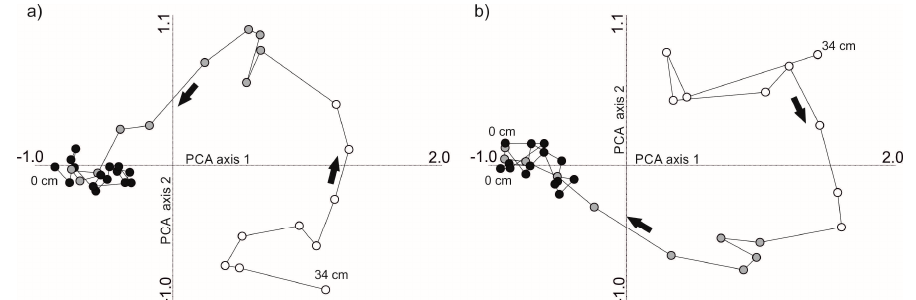
Figure 5. Principal component analysis (PCA) ordination diagrams for ( a ) cladoceran communities and ( b ) functional assemblages, where white symbols = reference period (pre-1960), gray symbols = eutrophication period (1960–1985), and black symbols = recovery (post-1985). The top (0 cm) and bottom (34 cm) samples of the core are marked, the black lines connect sample points chronologically, and the arrows indicate the direction of change. Table 2. Forward selection statistic (% explained, F- and p -values) of environmental variables (see abbreviations in Figure 2) in redundancy analysis (RDA) applied separately for cladoceran functional assemblages and taxonomic communities (and percentage of variance explained by all environmental variables) in Lake Maggiore since the period of continuous environmental monitoring. Most significant environmental variables are marked in bold type.